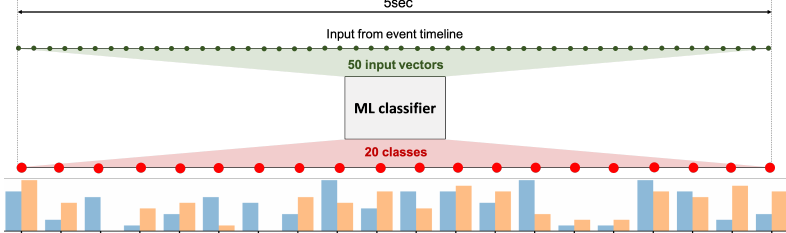
Figure 12. Diagram illustrating the input and output of the machine learning (ML) classifier: highlight start score function ( orange ) and highlight end score function ( blue ).